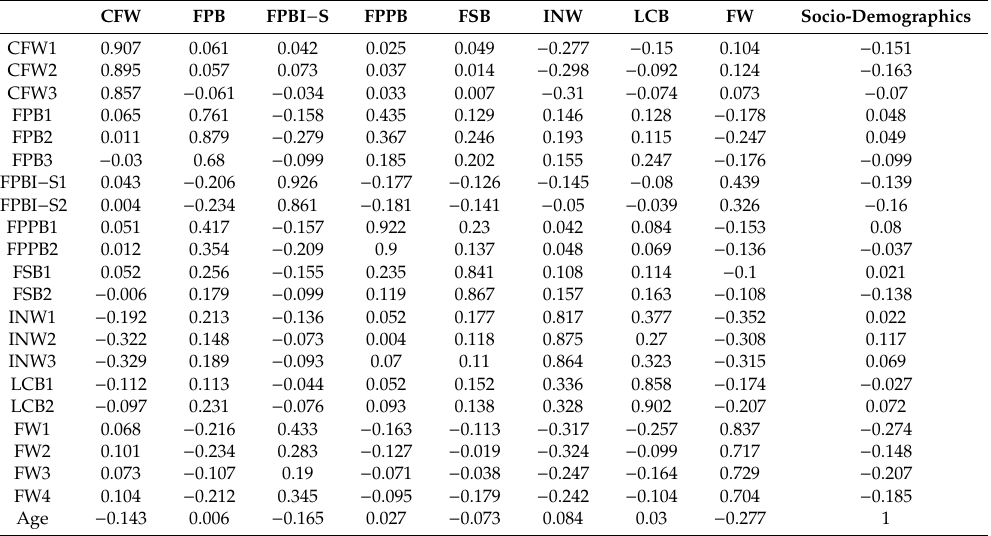
Table 3. Loadings and cross-loadings of all construct measures and their